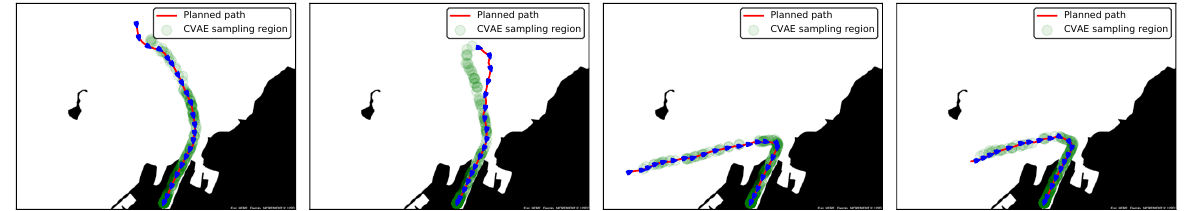
Figure 6: Examples of the path using RRT* with a learned CVAE sampler when the starting point is within human experience in the Trondheim harbor.